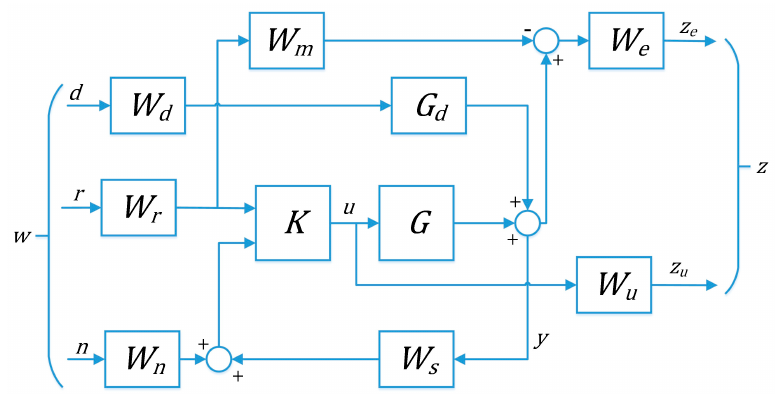
Figure 8. Signal-based (cid:1834) (cid:2998) control problem.